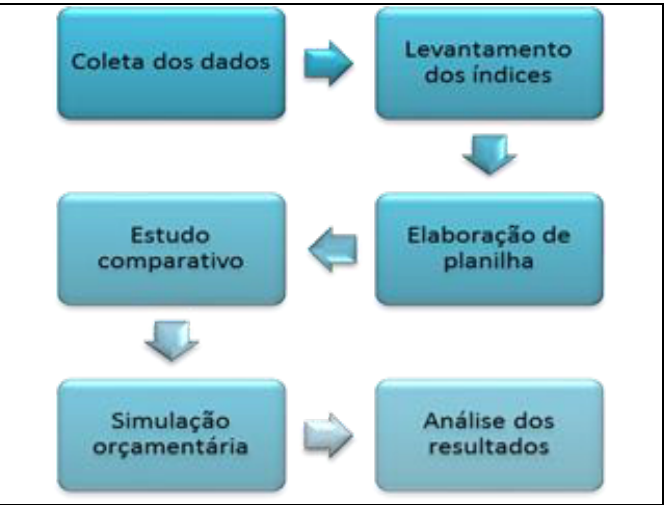
Figura 1: Fluxograma das etapas adotadas nesta pesquisa. Fonte: Autores, (2017).